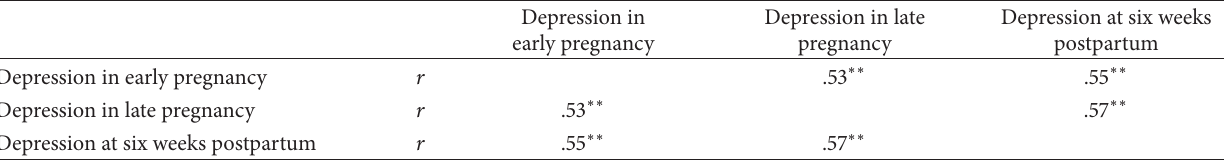
Table 4: Correlation of paternal depression from early pregnancy to six weeks